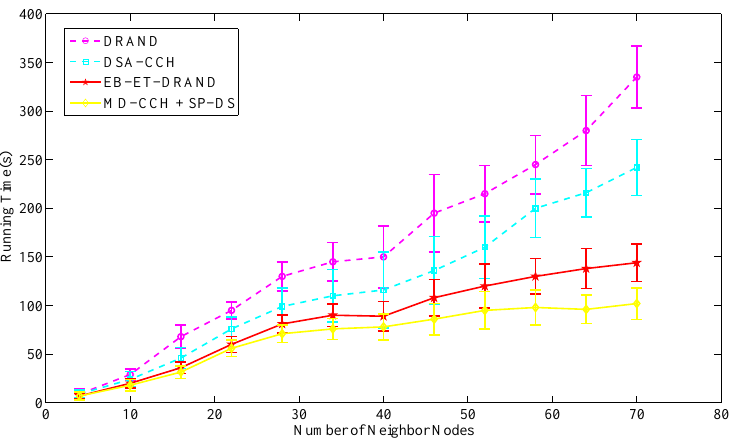
Figure 14. The average running time for successful allocating a time slot in different size of neighbor